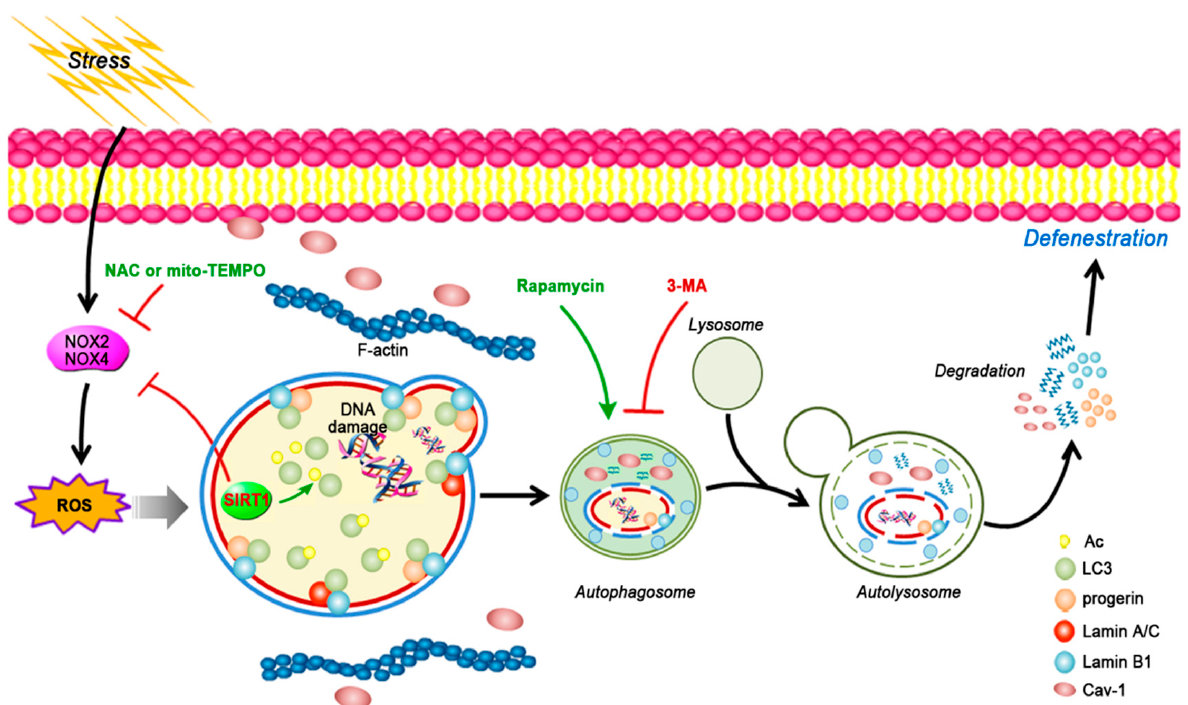
Figure 9. A schematic view of major signal pathways involved in the conclusion. Oxidative damage accelerates LSEC defenestration due to excessive accumulation of progerin and depletion of Cav-1. Overexpressing SIRT1 provokes progerin nucleophagic degradation via deacetylation of nuclear LC3 and inhibits depletion of Lamin B1 and Cav-1, contributing to reversing LSEC defenestration.